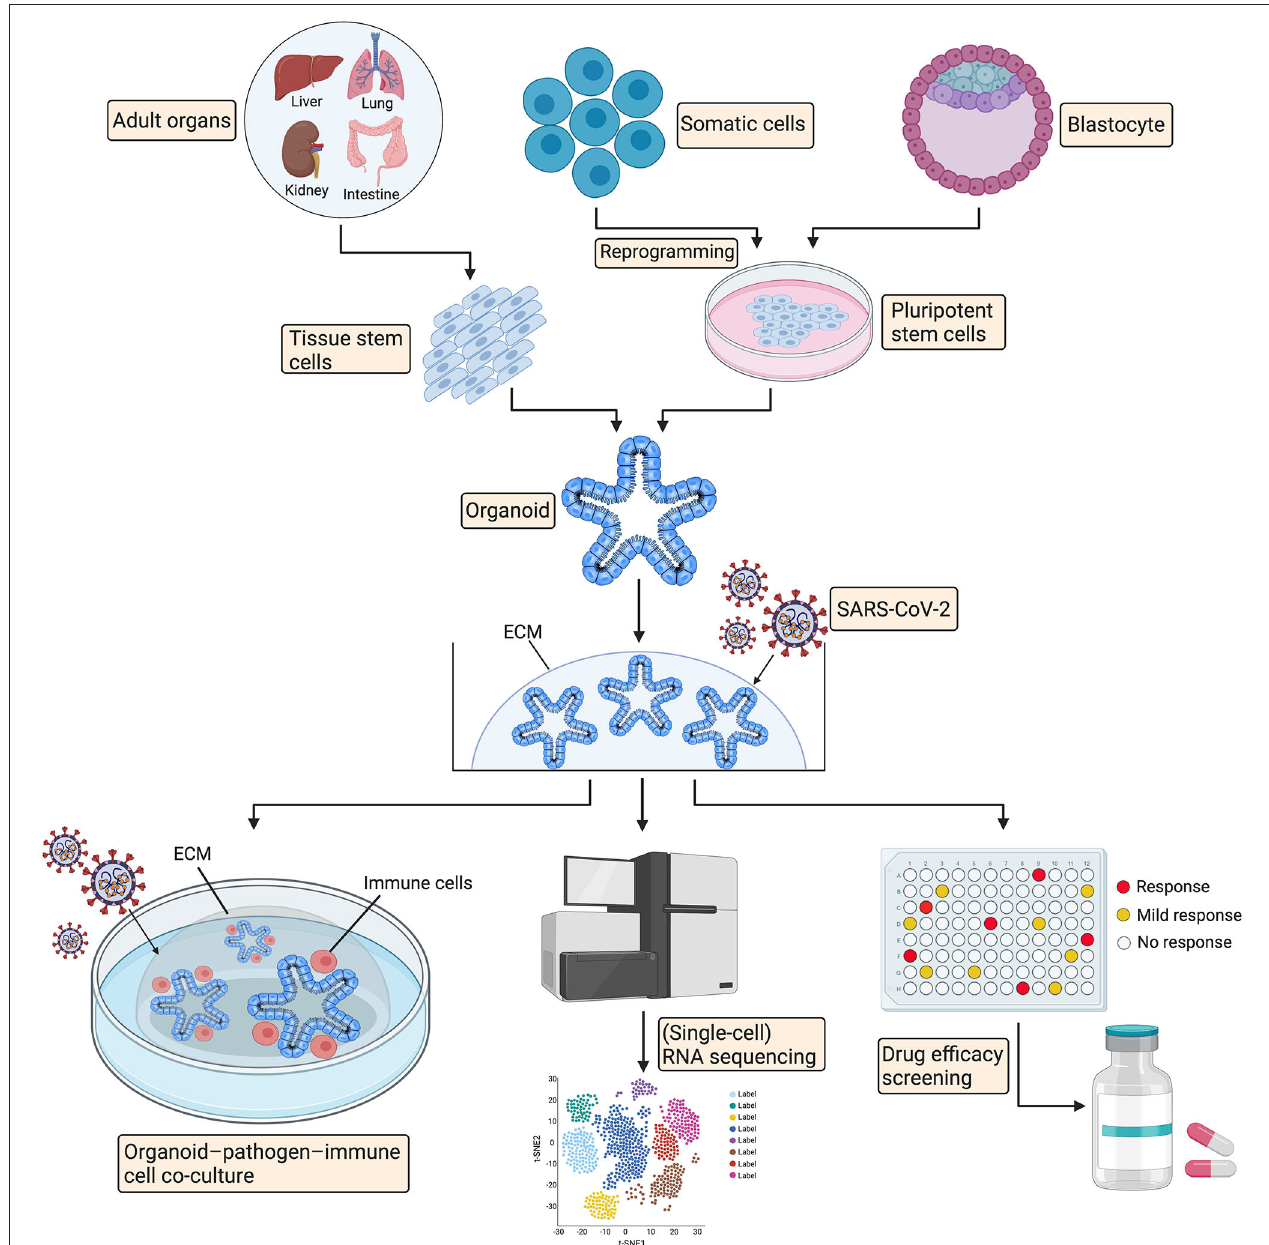
FIGURE 2 | Promising applications of organoid technology in COVID-19. Organoids can be established from adult tissue stem cells, induced pluripotent stem cells, or alternatively, from embryonic stem cells. Organoids can be utilized for pathogenesis investigation via organoid-pathogen-immune cell coculture system and RNA sequencing. Organoids can also facilitate high-throughput drug screening for COVID-19 treatment. ECM, extracellular matrix.